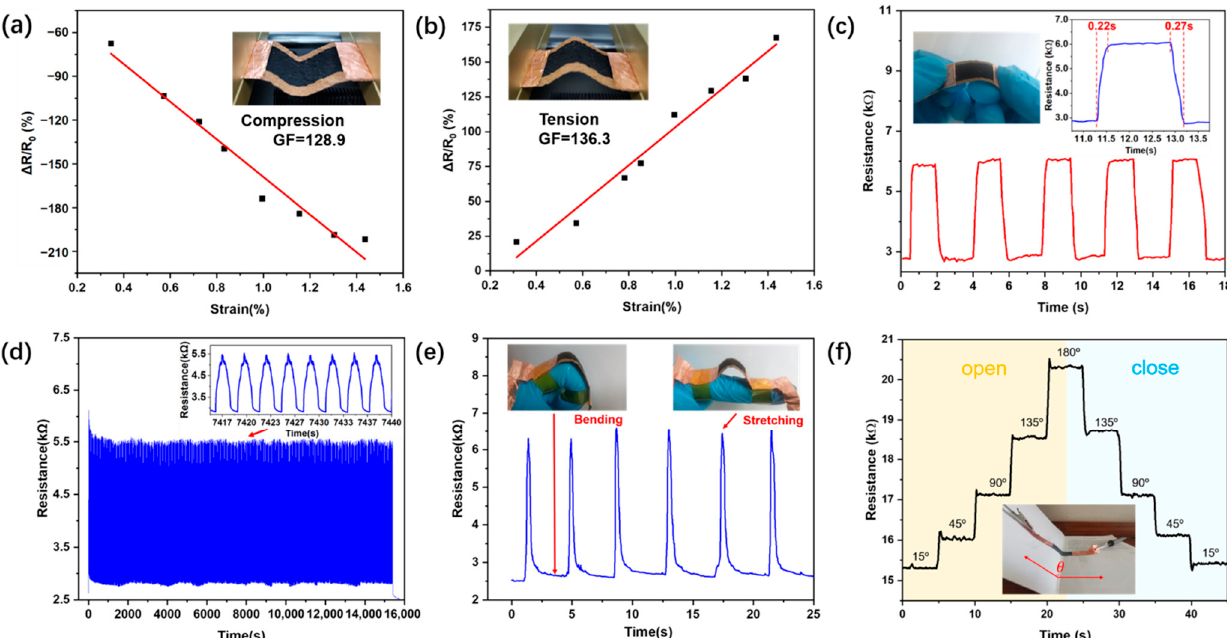
Figure 7. Performance of the sensor for detecting bending strains. Relative resistance changes as a function of applied strain. ( a , b ) are in accordance with the different bending directions (inward deflection (compression) or outward deflection (tension), respectively). ( c ) Response time of the sensor under bending strain. ( d ) Resistance change of the strain sensor during application of 5000 bending–unbending cycles. ( e ) Relative resistance changes during the finger bending tests. ( f ) Resistance change of the sensor under opening (orange area) and closing (blue area) the book states.